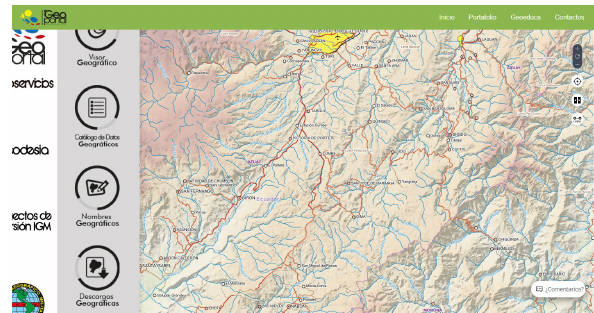
Figure 1. Part of the Azuay province in Ecuador, with the capital of Cuenca (in yellow) on top and Nabón in the